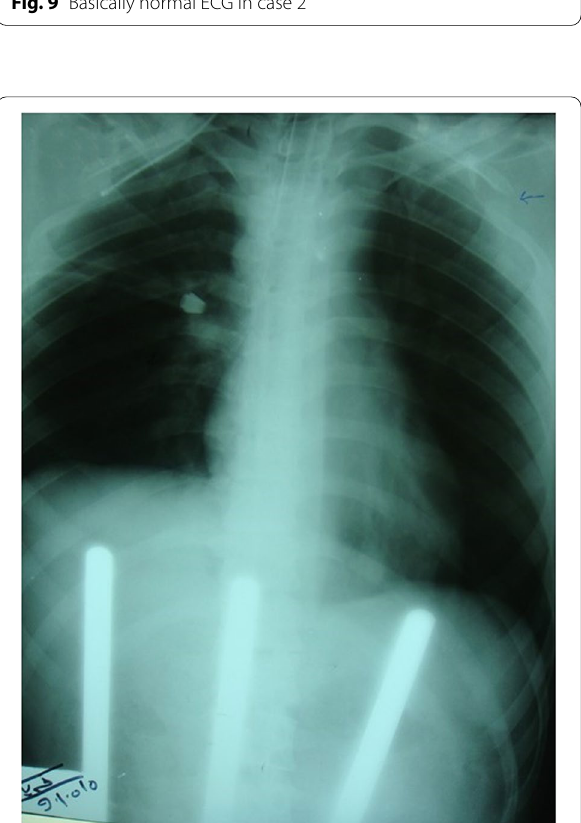
Fig. 10 Chest X-ray of the 2nd patient showing rib fracture and right-side chest tube for